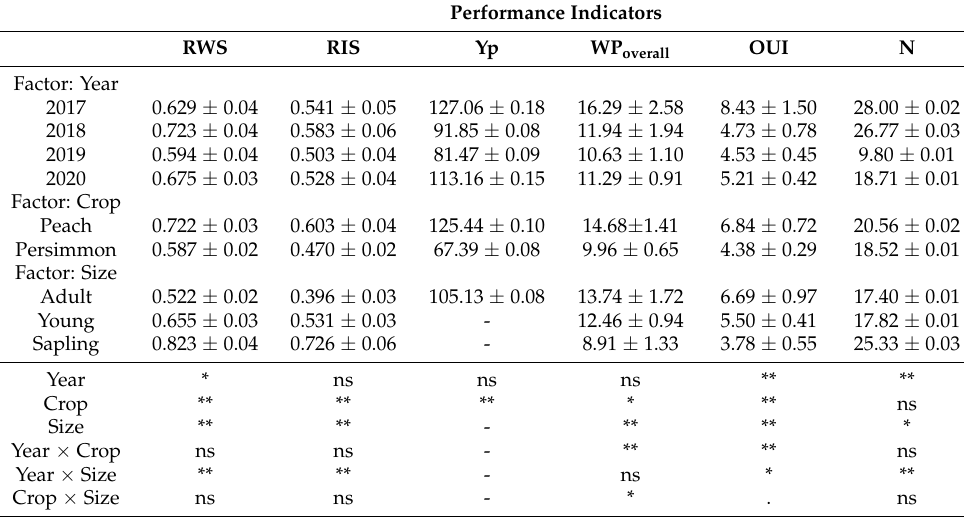
Table 6. Average values for the six calculated performance indicators: annual relative water supply, RWS, annual relative irrigation supply, RIS, yield performance, Yp (%), overall water use efficiency, WPoverall (kg/m 3 ), output per unit irrigation water, OUI (EUR/m 3 ), and percentage of nitrogen fertilization requirement supplied by irrigation water, N